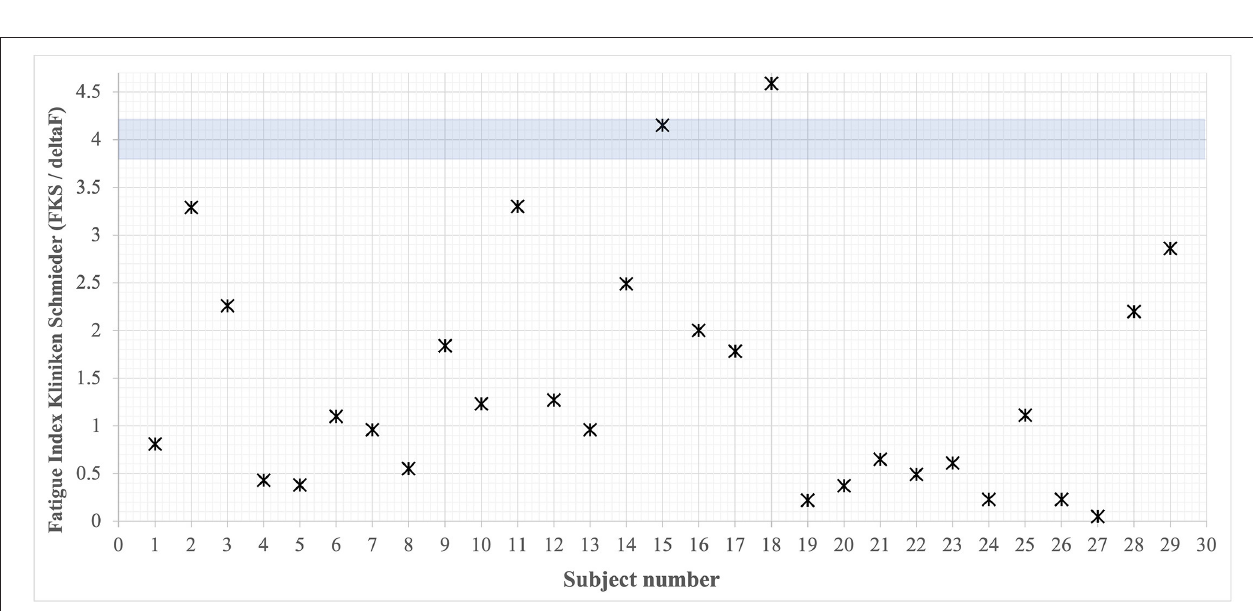
FIGURE 3 | Overview of all rehabilitants’ FKS. Cutoff value < 4 [based on (42)] defines no present performance fatigability. Only two patients lay above this critical value.